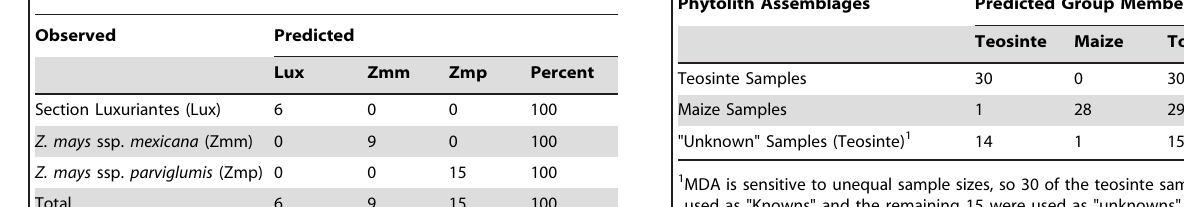
Table 4. Three-variable (A-2-B-3/3, A-1-B-4/4, C-4-D-4-4/4) MDA classification matrix of teosinte and Mexican maize samples (direct